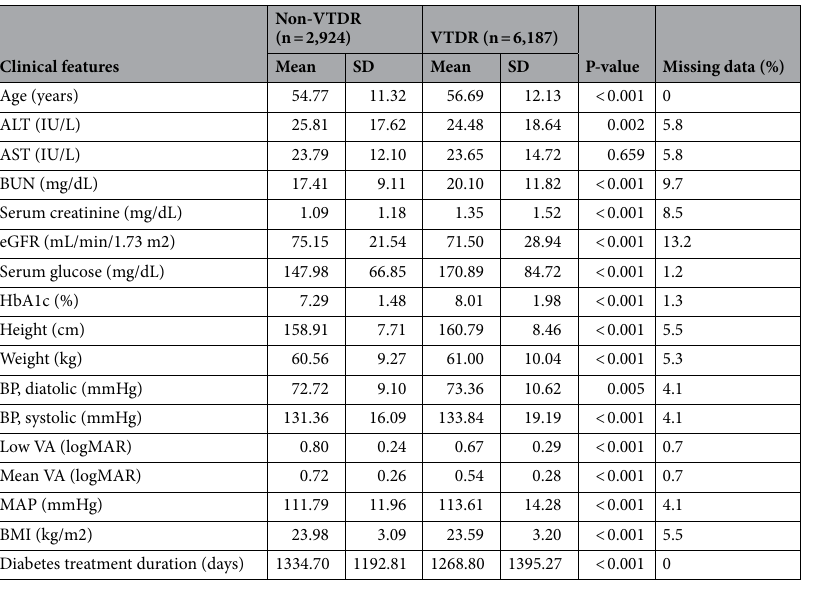
Table 1. Summary of clinical features (continuous variables) of type 2 diabetic patients with and without vision-threatening diabetic retinopathy in datasets of 10-year VTDR prediction. VTDR vision-threatening diabetic retinopathy, SD standard deviation, ALT alanine transaminase, AST aspartate transaminase, BUN blood urea nitrogen, eGFR estimated glomerular filtration rate, HbA1c glycated hemoglobin, VA visual acuity, BP blood pressure, MAP mean arterial pressure, BMI body mass index. P-value: Independent t-test between non-VTDR and